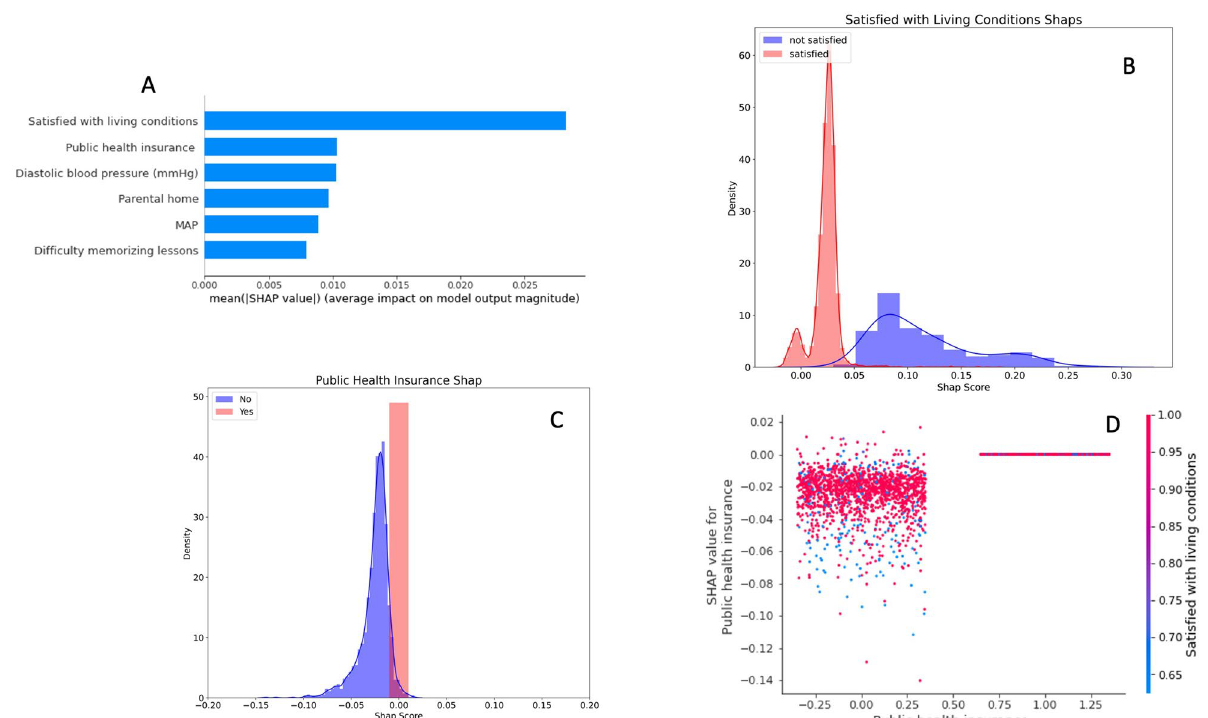
Figure 4. ( A ) This plot shows the top six most important features for predicting MDD. This is displayed as the mean of the absolute value of SHAP scores across all subjects for that given feature. A higher SHAP value indicates that the feature was important in informing the models prediction. ( B ) This plot displays the density distribution of SHAP values for the top performing feature in predicting depression. ( C ) This plot also displays the density distribution of SHAP values for the second most important feature in predicting MDD. Positive SHAP score indicates that the feature was indicative of the subject having MDD. ( D ) This is an interaction plot showing the effect of two features working together to inform the model. Here it is apparent that when a student does not have public health insurance, living conditions can partially inform